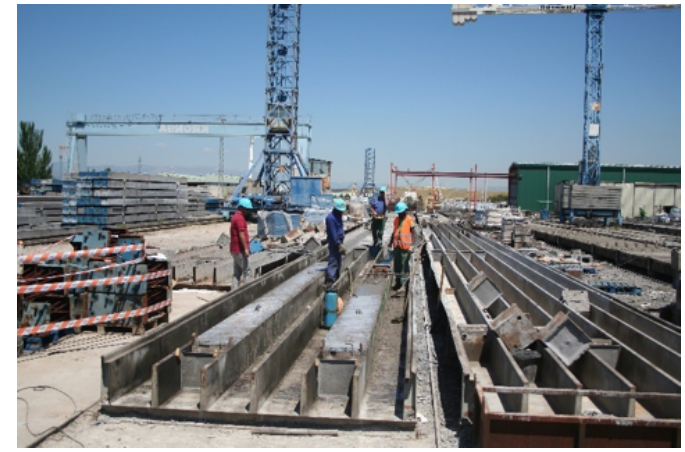
Figure 1. Precast pile at the factory